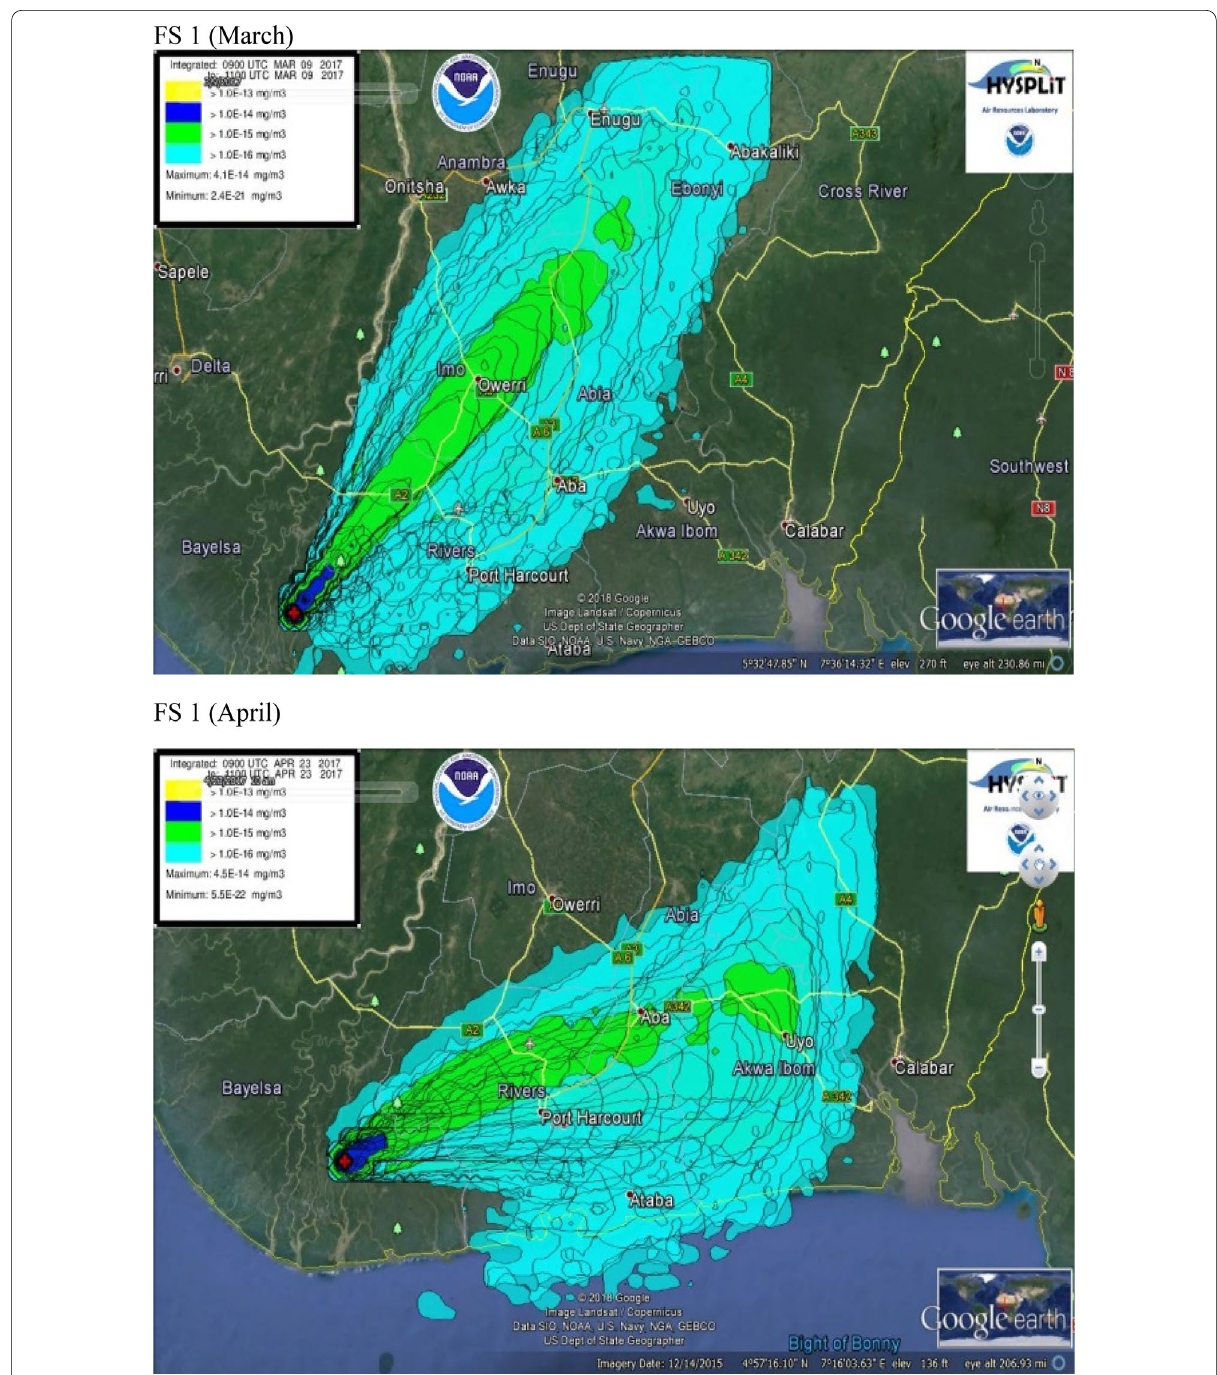
Fig. 5 Dispersion of PM 10 from FS 1–8 in March and April